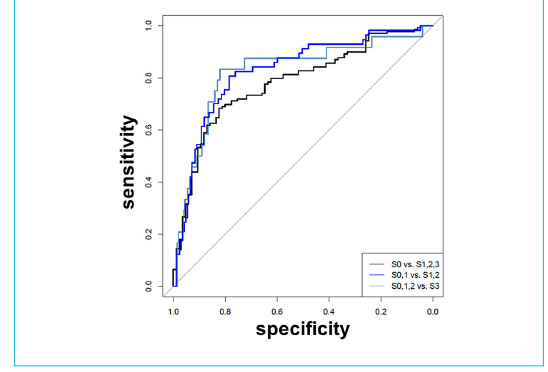
Figure 6: Receiver operating characteristic (ROC) curves of con- trolled attenuation parameter (CAP) in the diagnosis of: S ≥1